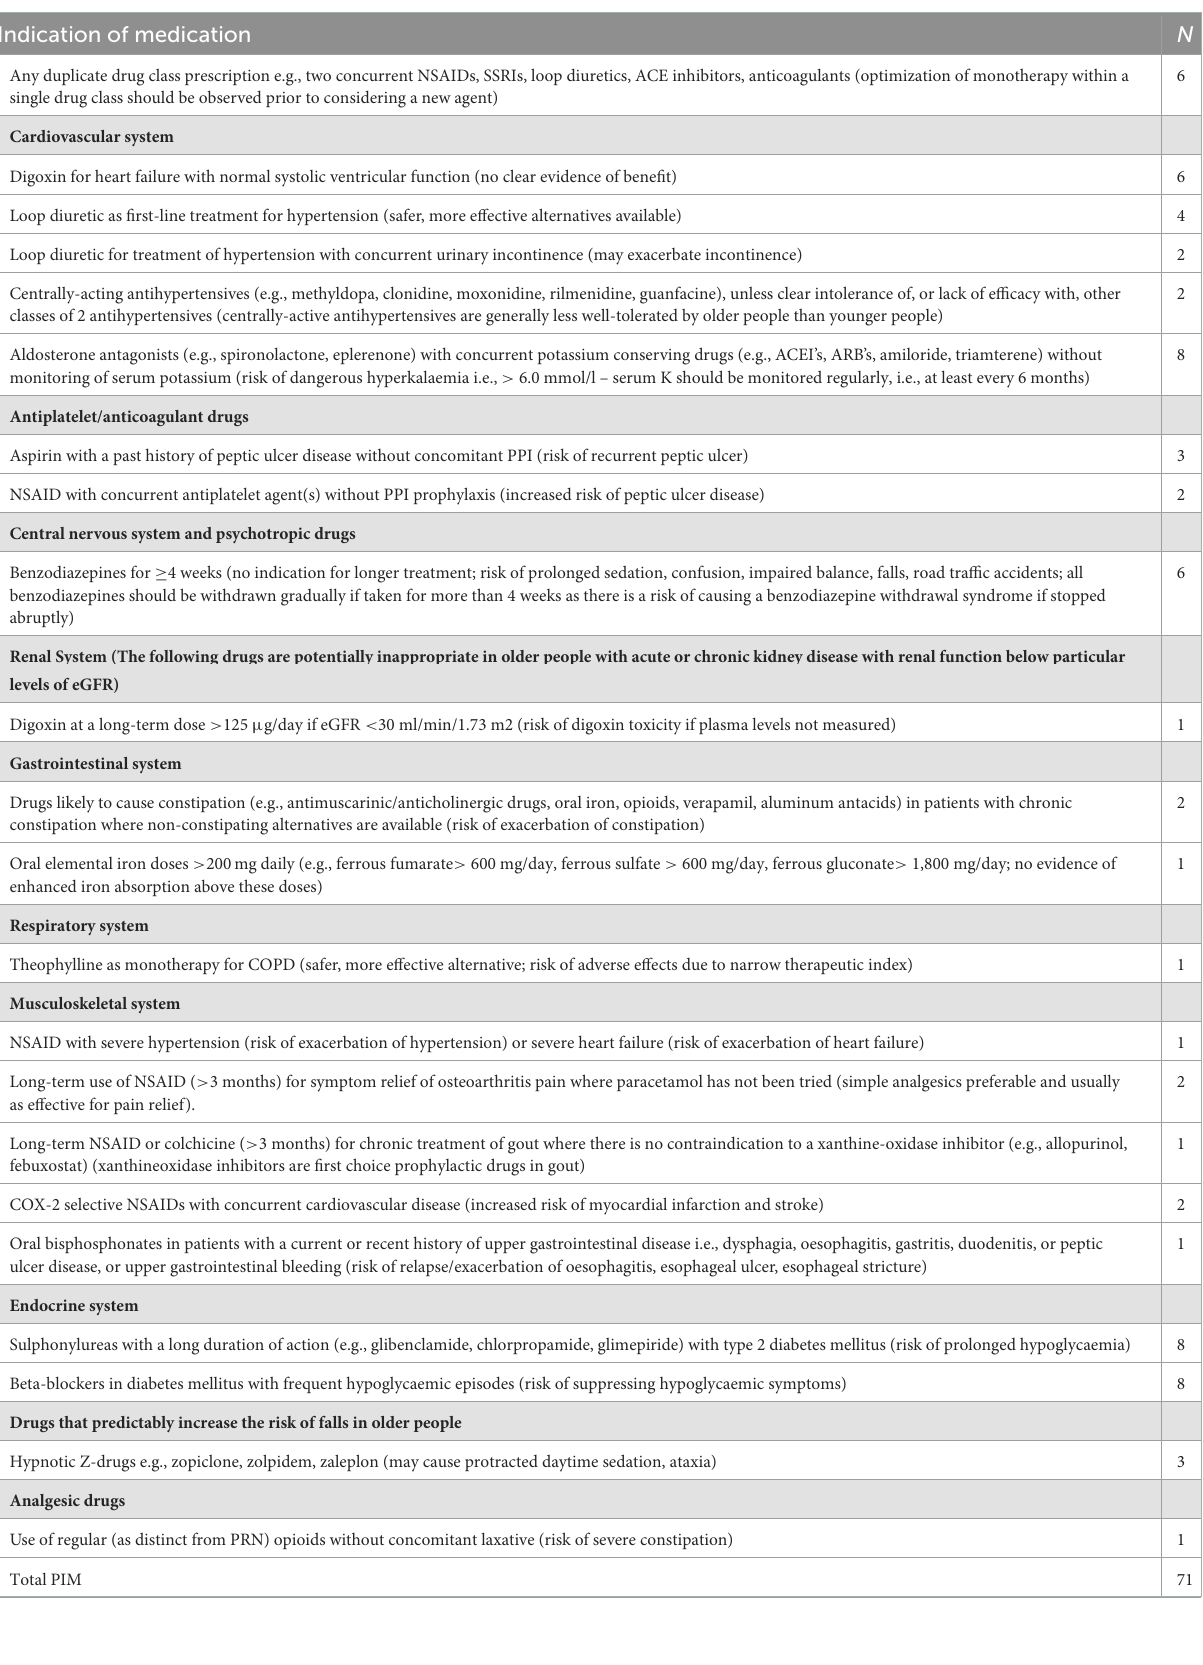
TABLE 4 Screening tool of older people’s potentially inappropriate prescriptions (STOPP). Indication of